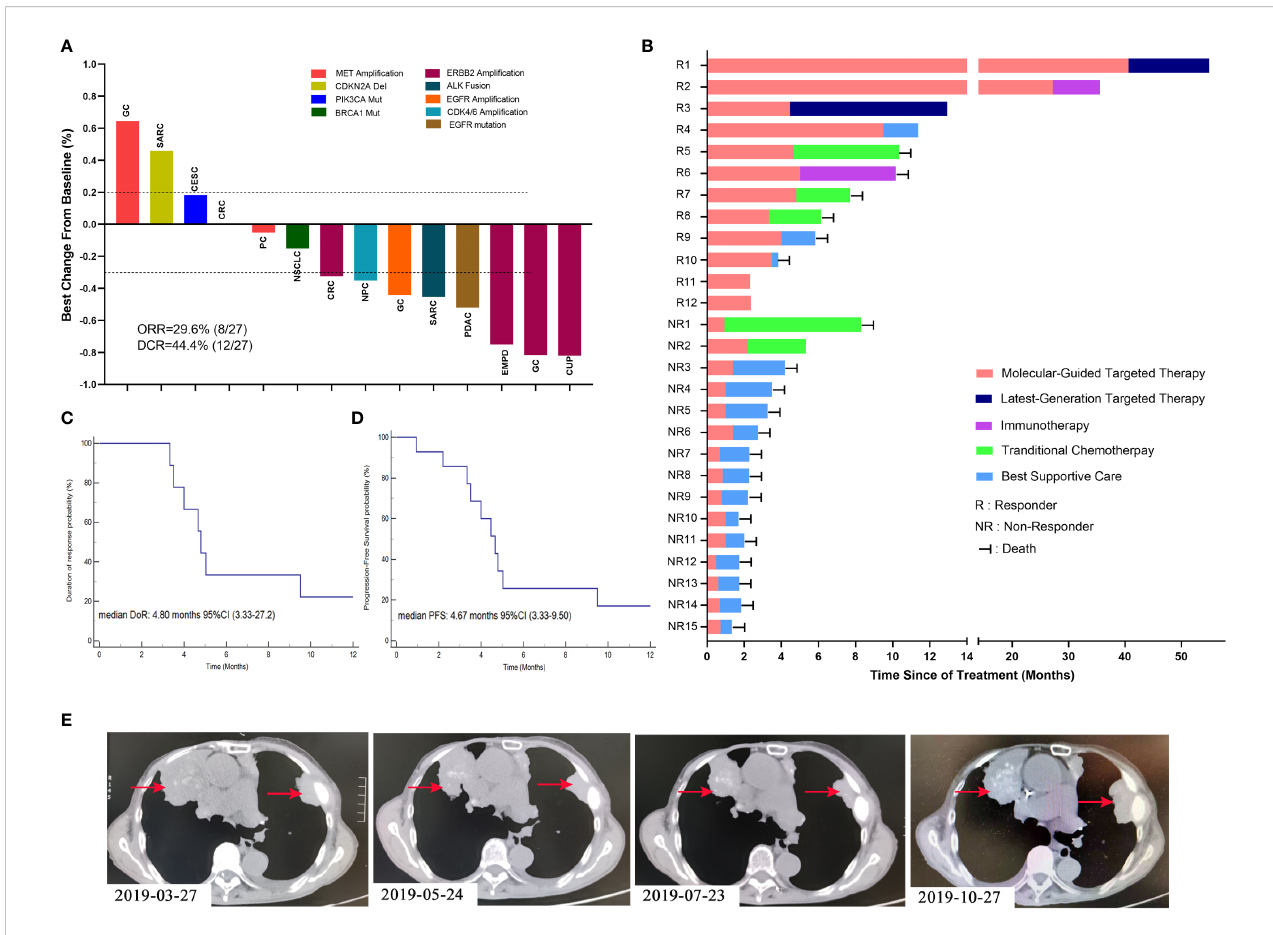
FIGURE 2 Ef fi cacy of molecular-guided targeted therapy among Chinese intractable cancer patients. (A) Waterfall plots of treatment response in 14 patients (another 13 patients had been discontinued from treatment for cancer-related death or poor performance before the fi rst response evaluation). (B) Follow-up of all 27 patients (R, responder, including partial respond and stable disease; NR, non-responder). (C) Duration of response of molecular- guided targeted therapy. (D) Progression-free survival of molecular-guided targeted therapy. (E) An 89-year-old patient with metastatic rectal cancer harboring ERBB2 ampli fi cation received pyrotinib (400 mg po qd) and achieved partial response for 5.9 months. GC, gastric cancer; SARC, sarcoma; CESC, cervical squamous cell carcinoma; PC, peritoneal cancer; NSCLC, non-small cell lung cancer; CRC, colorectal cancer; NPC, nasopharyngeal carcinoma; EMPD, extramammary Paget ’ s disease; CUP, cancer of unknown